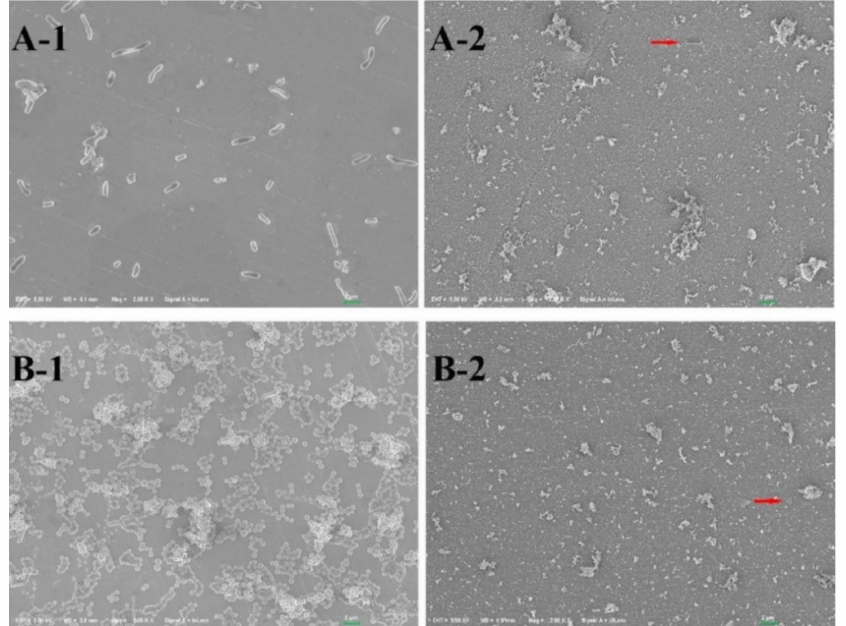
Figure 8. SEM images of: E. coli ( A ); and S. aureus ( B ) adhered on the surfaces of untreated samples ( A-1 and B-1 ) and DA-SS AgNPs ( B-2 and B-2 ). According to the work of (Reproduced from [91], published by Elsevier,